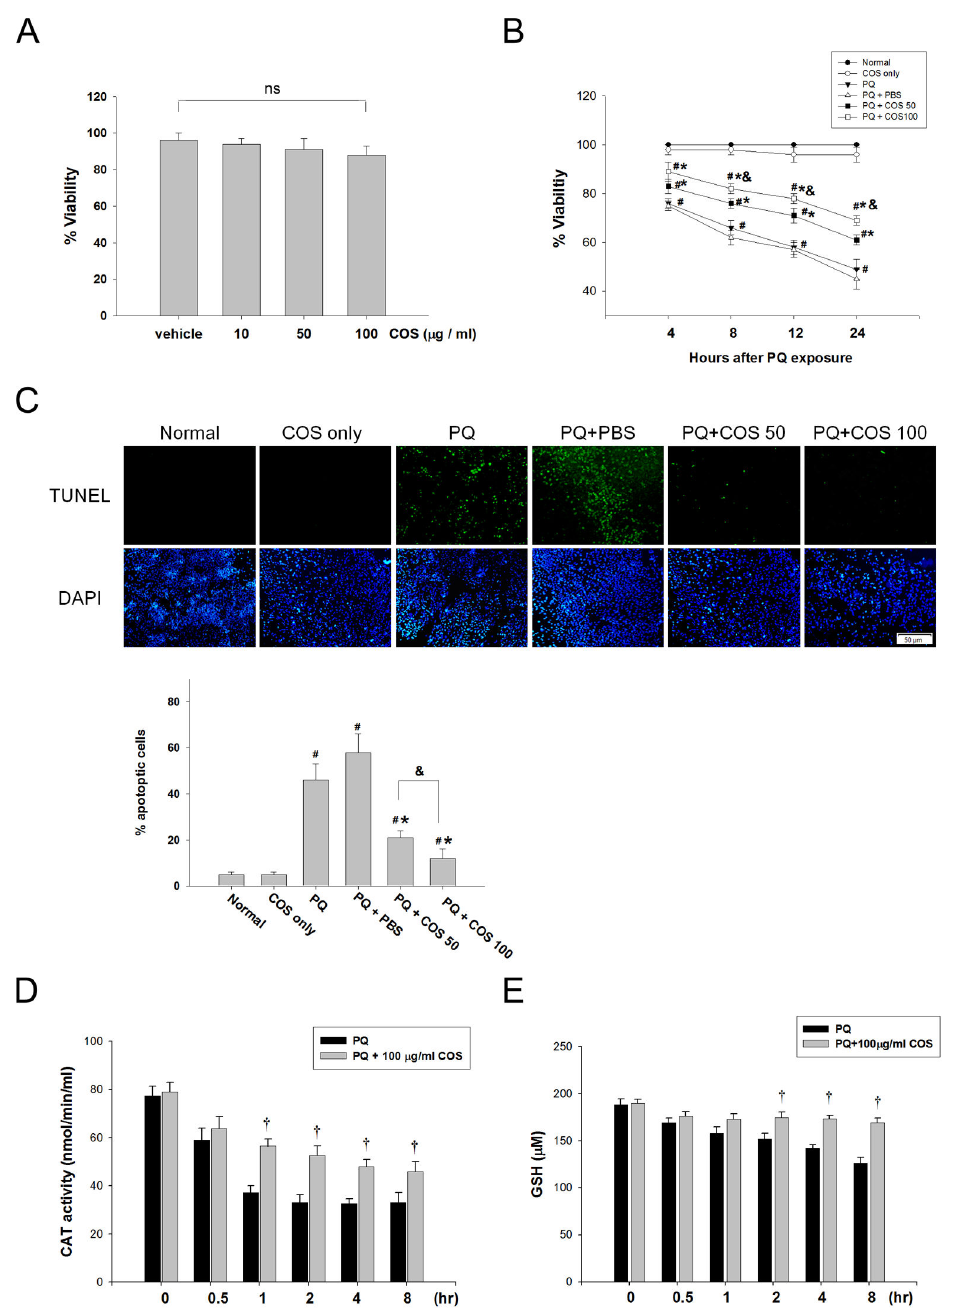
Figure 6. The influence of COS on PQ-induced cell death, apoptosis and antioxidative enzyme in RGC-5 cells. (A) Effects of COS on RGC-5 viability determined by MTT assays. RGC-5 cell were incubated for 24 h with vehicle or COS at indicated concentrations. (B) COS decreased PQ-stimulated RGC-5 cell death. RGC-5 cell were stimulated with 0.5 mM PQ and treated with 50 or 100 μg/ml COS for indicated time. (C) Inhibition by COS of PQ-induced apoptosis. RGC-5 cell were stimulated with 0.5 mM PQ and treated with 50 or 100 μg/ml COS or PBS for 6 hours. Cells apoptosis was analyzed by TUNEL stain. Percent apoptotic RGC-5 cells were obtained by counting at least 400 cells. Data were expressed as mean ± SD. ns, Non-significant compared with vehicle-treated control. (* P < 0.05 compared with PQ only or PBS-treated group; # P < 0.05 compared with normal; & P < 0.05 by ANOVA with post hoc Bonferroni test; N=3 in each group) (D) COS activated catalase activity in PQ-stimulated RGC-5. RGC-5 cell were stimulated with 0.5 mM PQ and treated with 100 μg/ml COS for indicated time. (E) COS increased GSH levels in PQ- stimulated RGC-5. († P < 0.05 compared with PQ only by Student’s t-test; N=3 in each group). doi: 10.1371/journal.pone.0077323.g006 PLOS ONE |